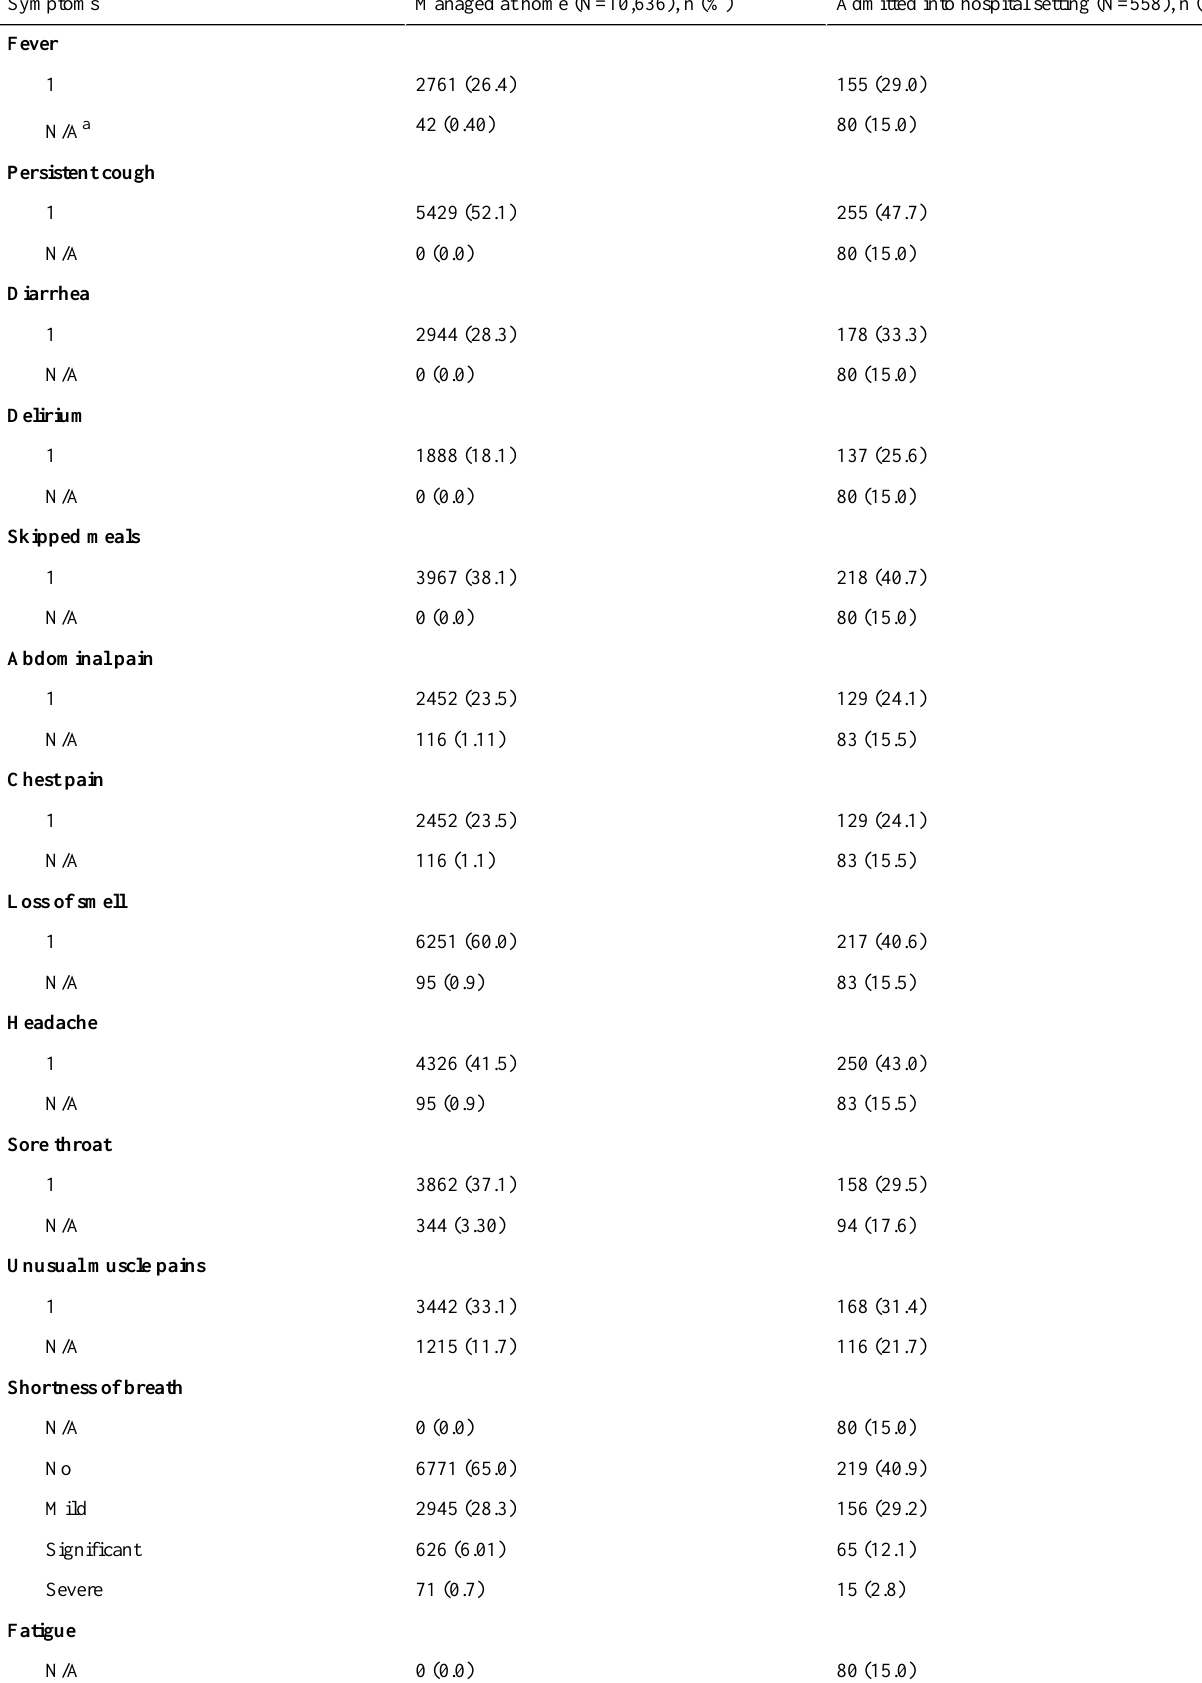
Table 1. Features of symptoms investigated in relation to whether a user was seeking treatment. All features were binary except for shortness of breath and fatigue, which were